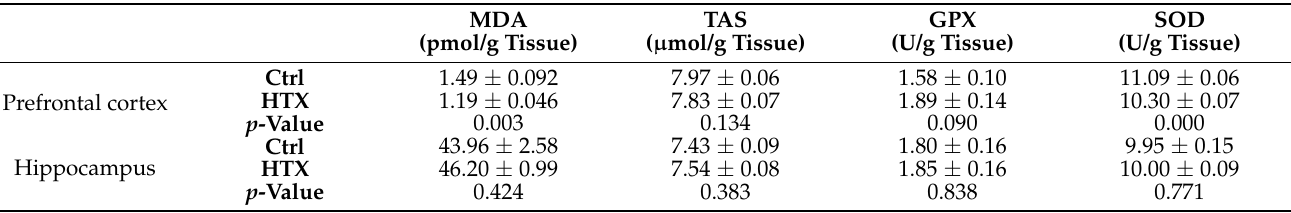
Table 4. Effect of maternal supplementation with HTX on oxidative stress markers and antioxidant enzymes in the 100-day-old fetuses (mean ±